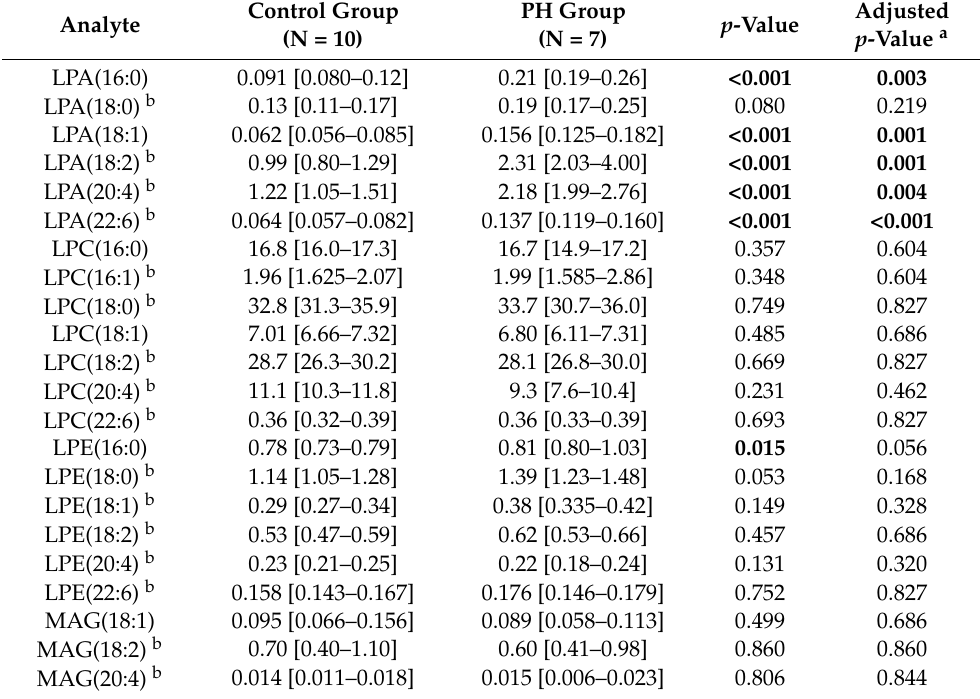
Table 3. Impact of PH induced by SuHx on LPA, LPL and MAG